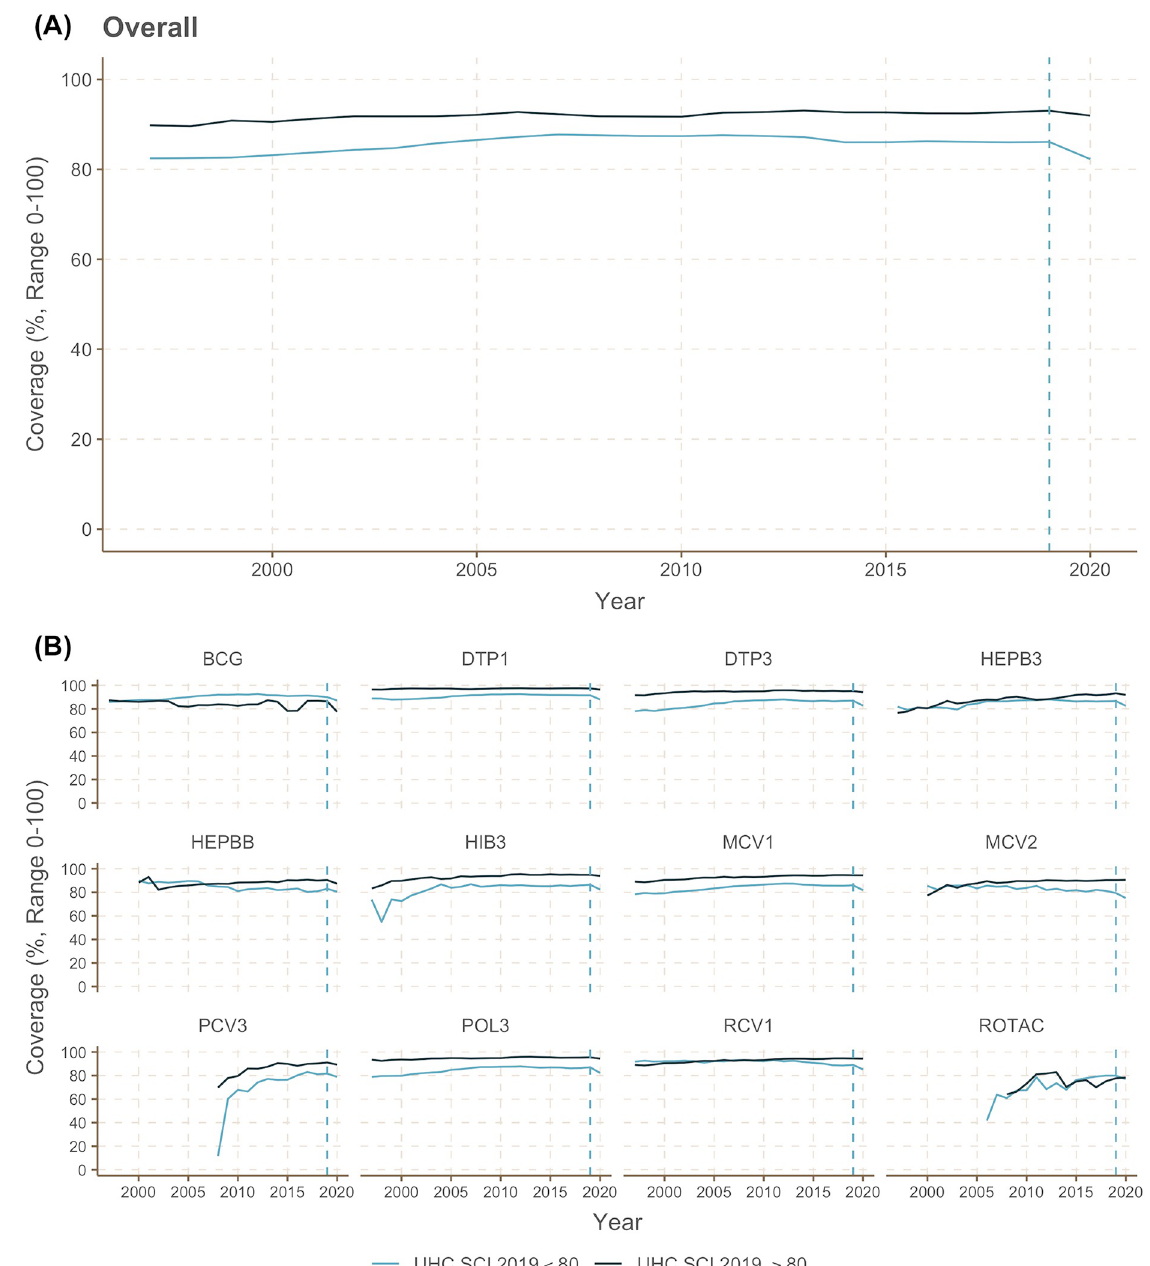
Fig 1. Change in overall vaccine coverage (A) and vaccine-specific coverage (B) globally by UHC Service Coverage Index 2019 (UHC SCI � 80 vs. UHC SCI < 80) between 1997 and 2020. Abbreviations: BCG = Bacille Calmette-Gue´rin; DTP1 = diphtheria, tetanus toxoid, and pertussis containing vaccine—first dose; DTP3 = diphtheria, tetanus toxoid, and pertussis containing vaccine—third dose; HEPB3 = third dose; HEPBB = hepatitis B vaccine—birth dose; HIB3 = Haemophilus influenzae type B containing vaccine; MCV1 = measles containing vaccine—first dose; MCV2 = measles containing vaccine—third dose; PCV3 = pneumococcal conjugate vaccine—third dose; POL3 = polio containing vaccine—third dose; RCV1 = rubella containing vaccine—first dose; ROTAC = rotavirus vaccine—second or third dose; UHC SCI = UHC Service Coverage